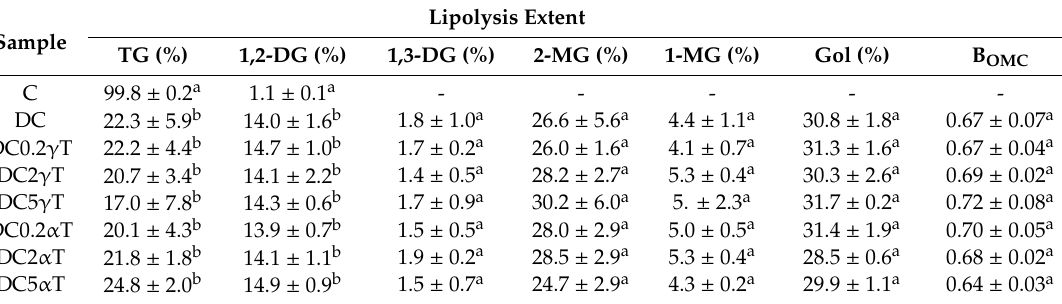
Table 1. Lipolysis extent. Molar percentages of triglycerides (TG), diglycerides (1,2-DG and 1,3-DG), monoglycerides (2-MG and 1-MG) and glycerol (Gol), in relation to the total glyceride